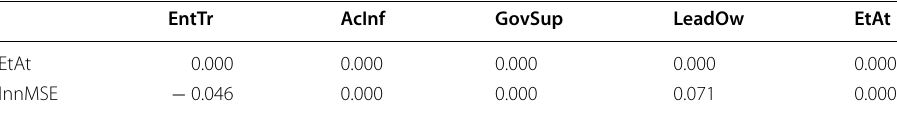
Source: Own Survey